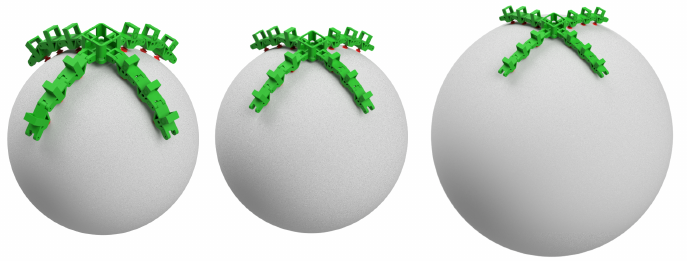
Figure 9. Rendered images of spheres, from left to right the diameter of the sphere is respectively three, four, and six times the length of Polyps